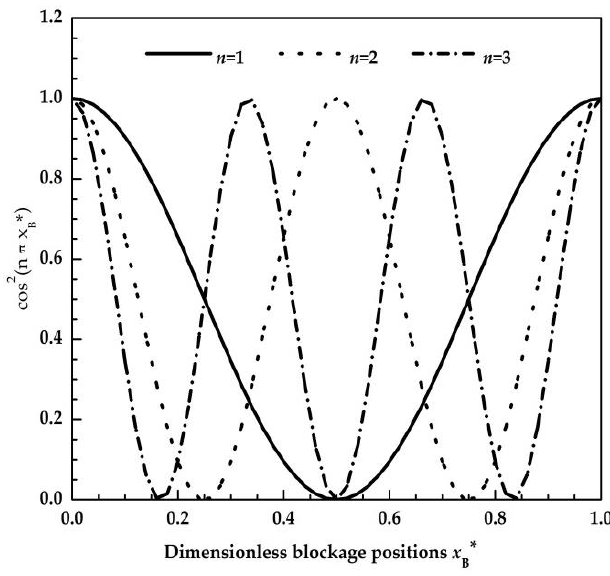
Figure 3. Blockage attenuation diagram of different harmonic components.